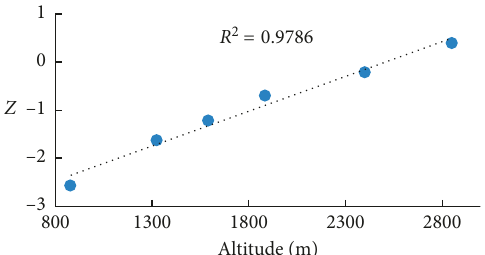
Figure 9: Relationships between the statistic Z value of annual precipitation and